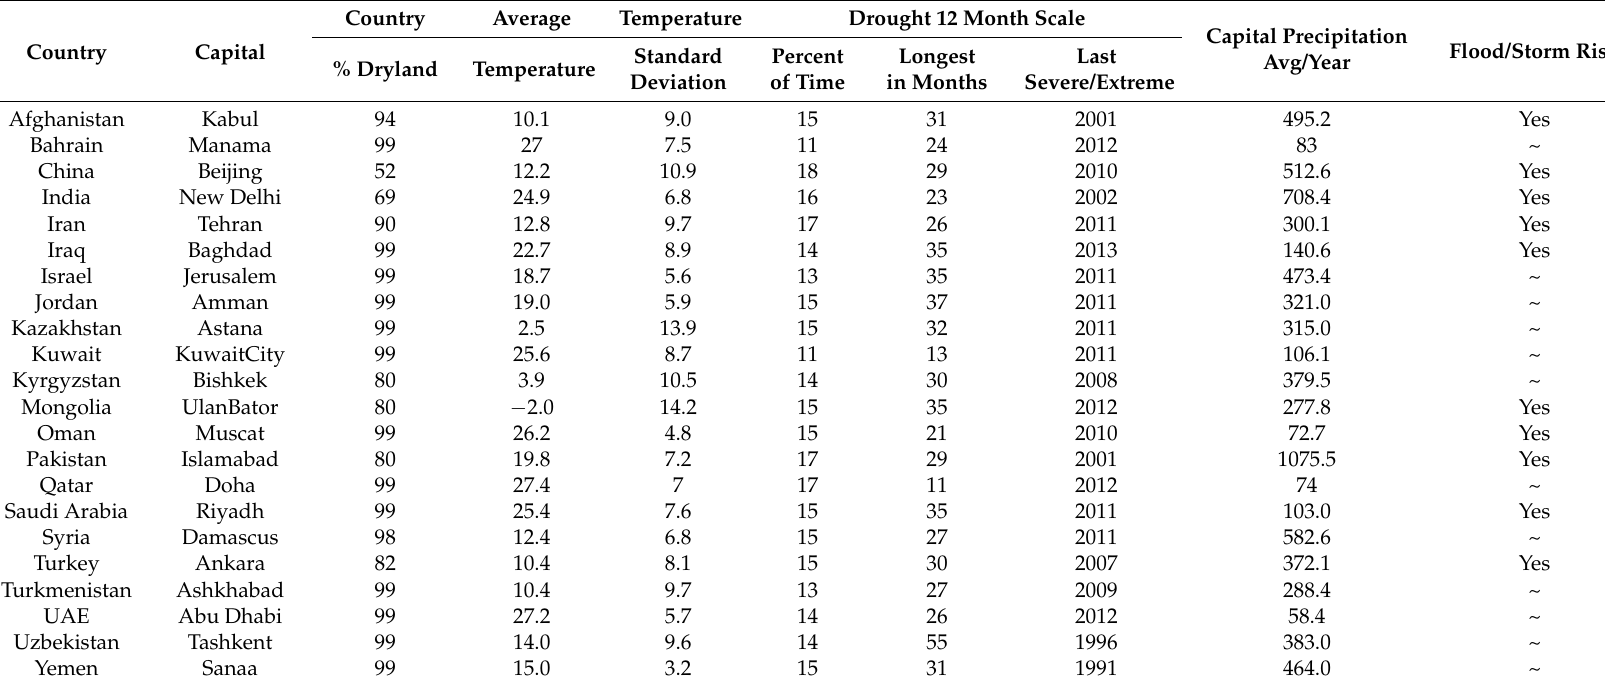
Table 2. Physical data on selected Asian dryland countries (IPCC 2012). Within drylands the data use national capitals to cite temperature, precipitation and drought